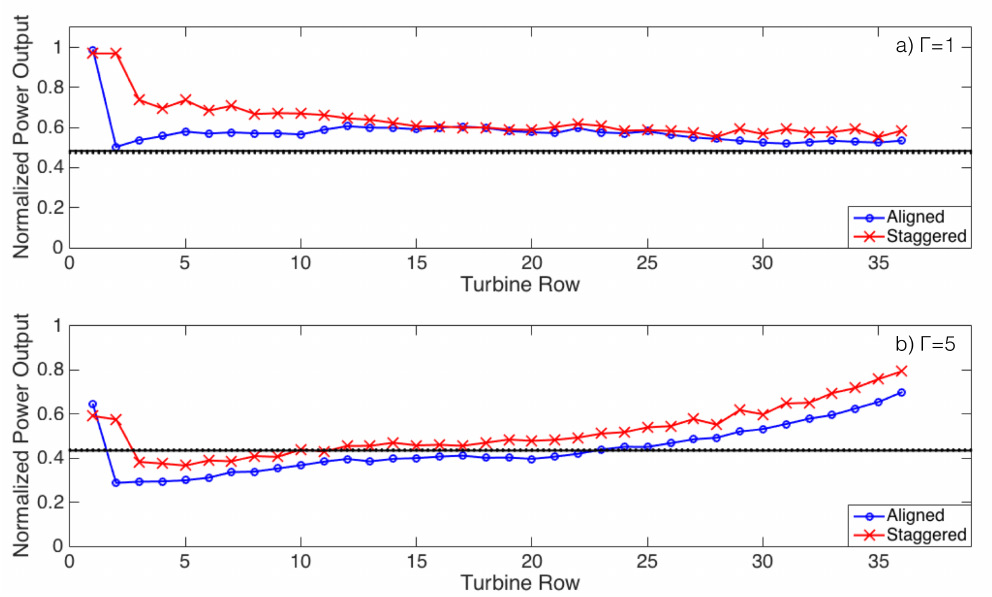
Figure 11. Power production at different turbine rows inside the wind farms for the ( a ) Γ = 1 K/km cases and ( b ) Γ = 5 K/km cases, normalized by the power production of a single turbine operating under the same lapse rate. The black horizontal dotted and solid lines are the power production of a wind turbine for the corresponding aligned and staggered infinite wind farm cases,